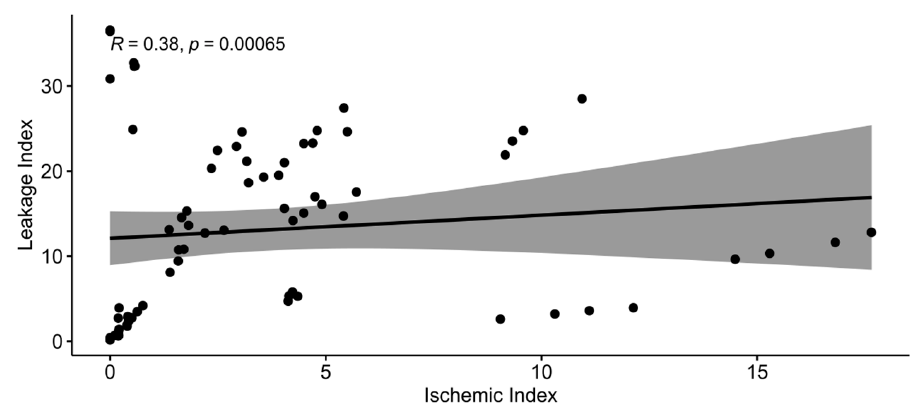
Figure 8. Spearman’s correlation between ischemic and leakage indexes.